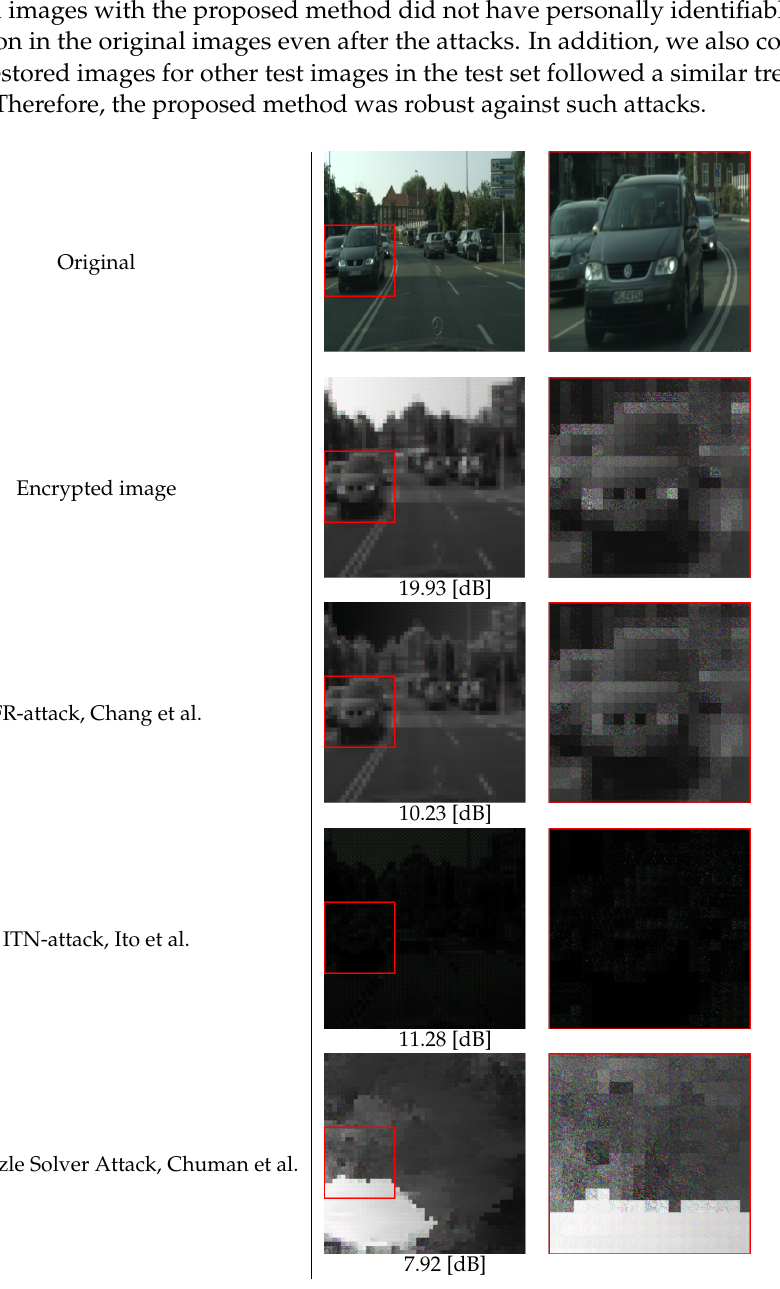
Figure 7. Examples of images restored from encrypted ones, see [26,34–36]. Zoom-ins of red-framed regions are shown on right side of each image. The red boxes represent sensitive information such as license plates. PSNR values are given under